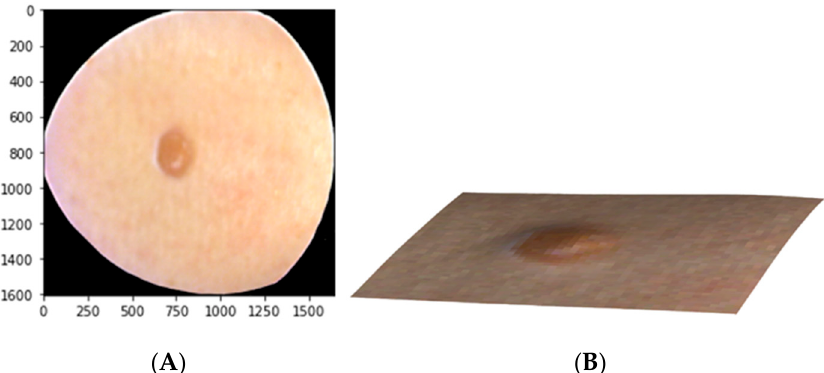
Figure 3. Example of the data after the raw image pre-processing. Reconstruction of an ID nevus using red-green-blue (RGB) from the albedo images ( A ) and its skin-surface model ( B